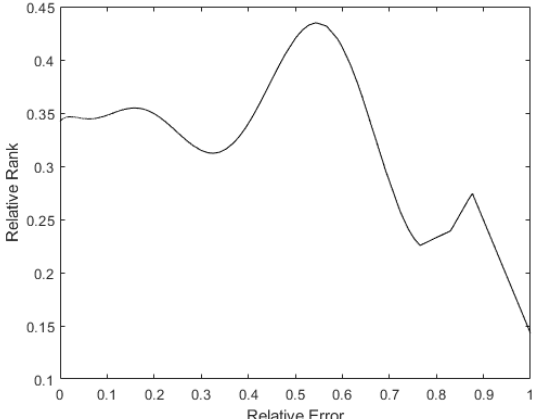
Figure 18. Polynomial regression of relative rank to relative error on X 2 .